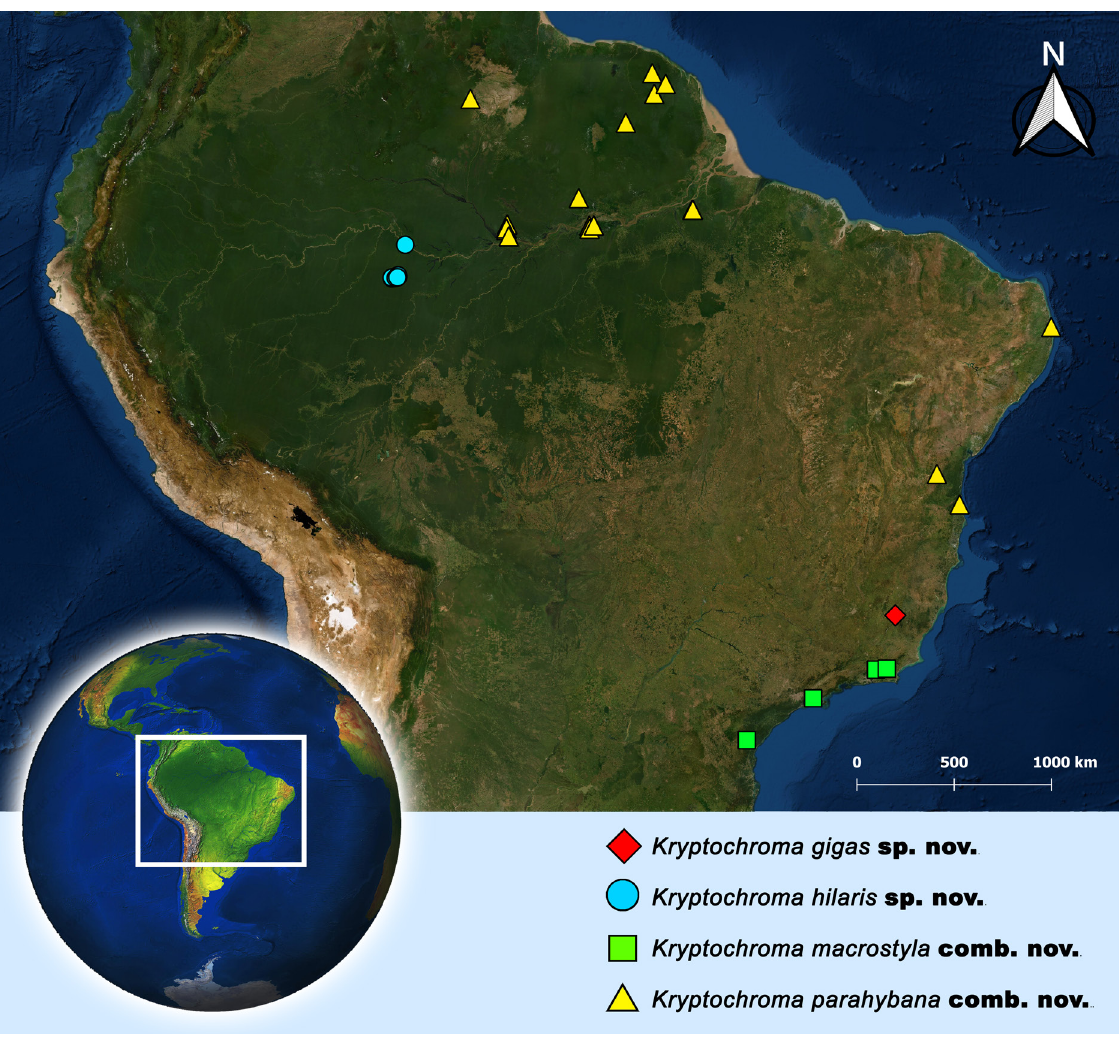
Fig. 9. Distribution records of species of Kryptochroma Machado gen.